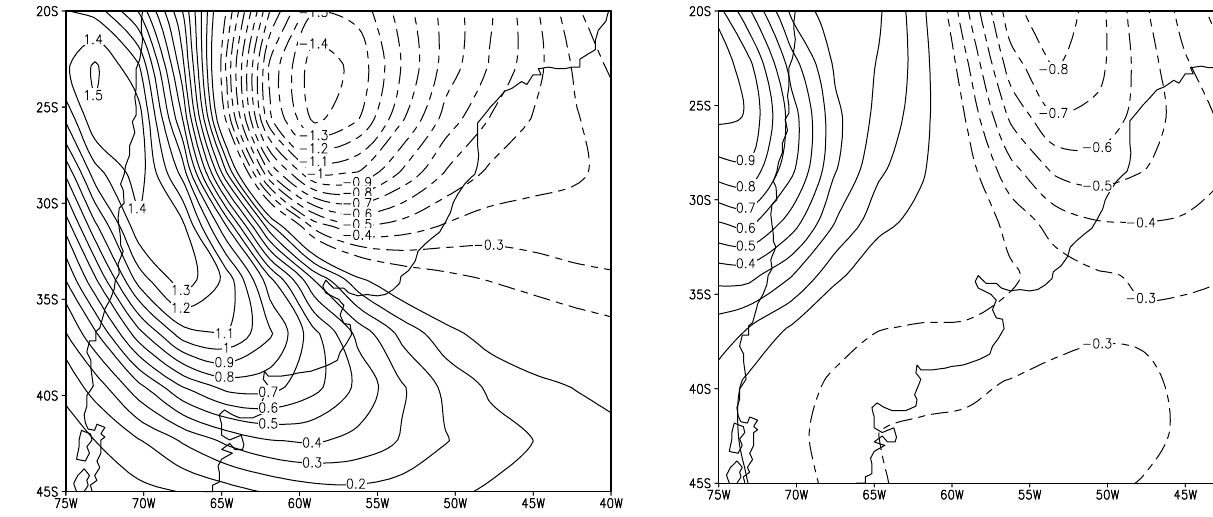
Figure 7 : Surface temperature anomalies (ºC) on day 10 of integrations, corresponding to - σ basic Fig. 8. Surface temperature anomalies ( ◦ C) on day 10 of integra- Fig. 7. Surface temperature anomalies ( ◦ C) on day 10 of integra- tion, corresponding to the mean winter basic state experiment with estate experiment with the forcing at 120ºE-15ºS Figure 8 : Surface temperature anomalies (ºC) on day 10 of integration, corresponding to the tions, corresponding to − σ basic estate experiment with the forcing the forcing at 120 ◦ E–15 ◦ at 120 ◦ E–15 ◦ S. mean winter basic state experiment with the forcing at 120ºE-15ºS